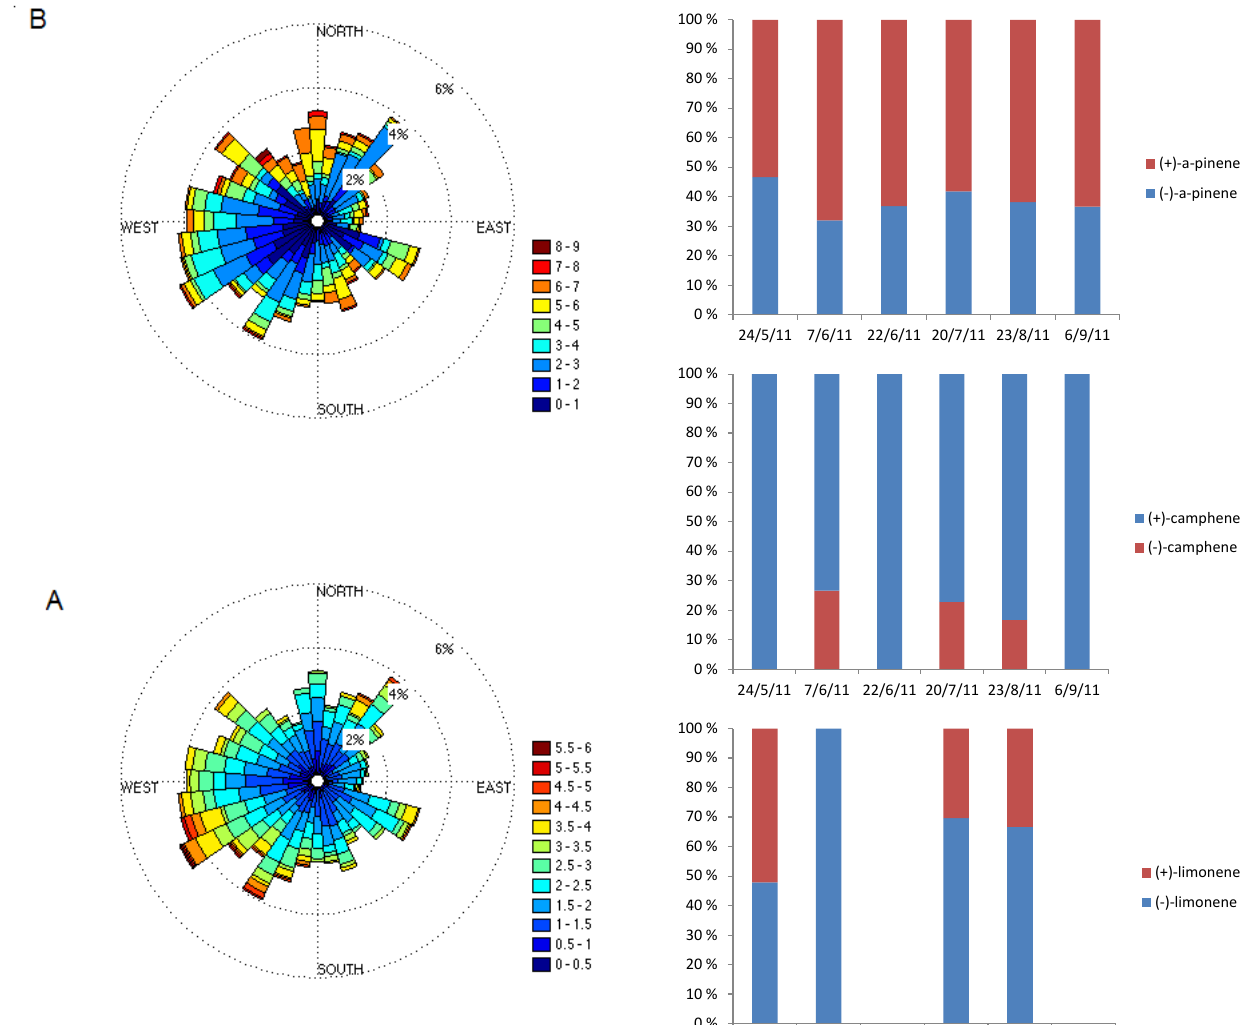
Fig. 5. Wind direction distribution (A) at Hyyti¨al¨a and monoterpene mixing ratio distribution in different wind direction (B) . Monoter- pene mixing ratios are presented in the logarithmic scale. Fig. 6. The contribution of ( + ) and ( − ) enantiomers in α -pinene, limonene and camphene mixing